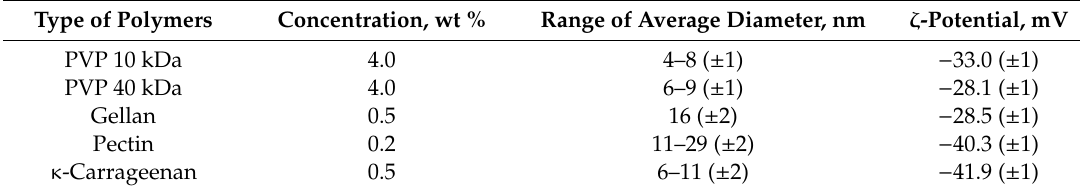
Table 1. Size distribution and ζ -potential of AuNPs synthesized and stabilized using synthetic and natural polymers. The standard deviations are given in parentheses.